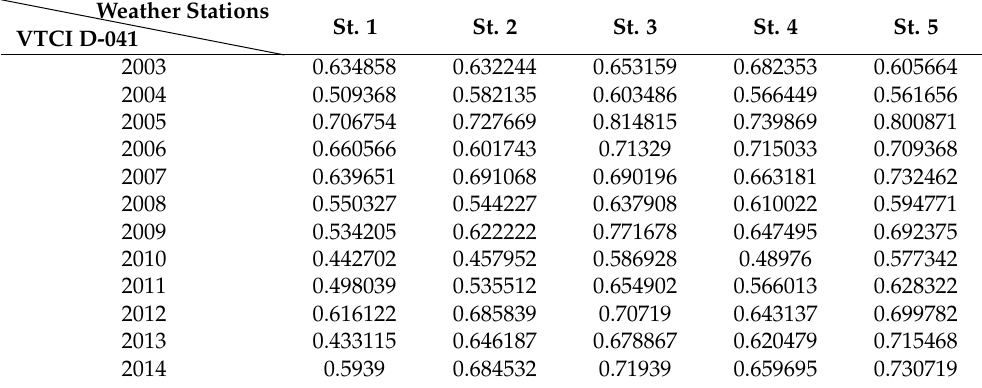
Table 1. VTCI values in each of five metrological stations (St.) at D-073 during 2003–2014, per pixel area.